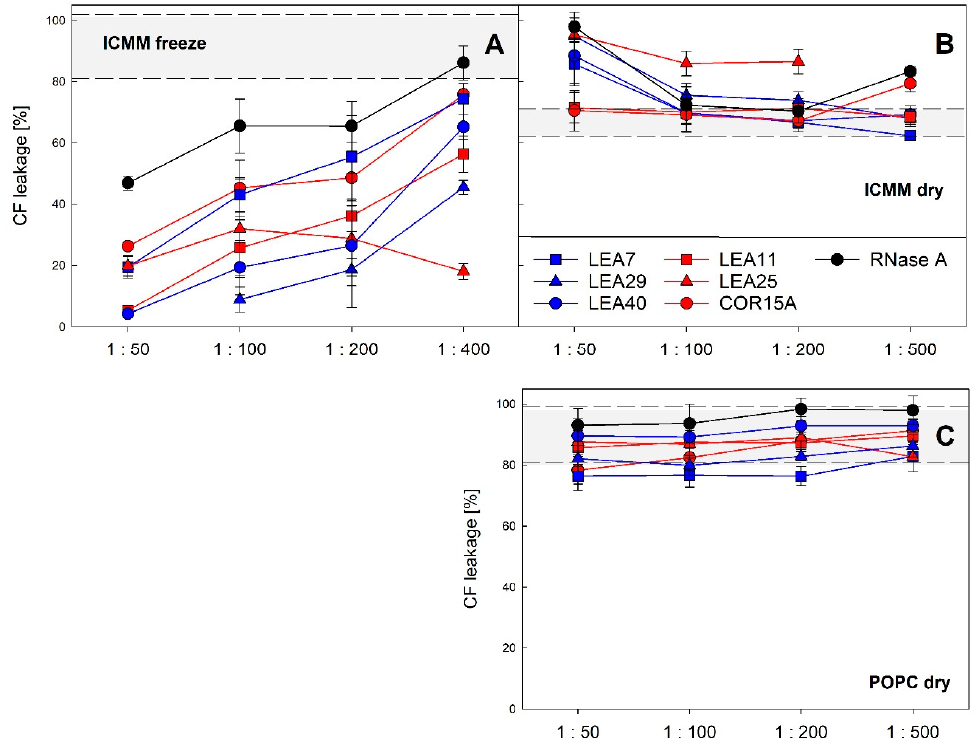
Figure 13. Liposome stability after a freeze/thaw cycle (A) or a dehydration/rehydration cycle (B, C). The integrity of large unilamellar ICMM vesicles, composed of 40% monogalactosyldiacylglycerol (MGDG), 30% digalactosyldiacylglycerol (DGDG), 15% sulfoquinovosyldiacylglycerol (SQDG) and 15% egg phosphatidylglycerol (EPG) (A, B) or of pure 1-palmitoyl-2-oleoyl-phosphatidylcholine (POPC) (C) was assayed as leakage of the soluble marker CF. The samples contained the indicated LEA_4 proteins or RNase A as reference protein at different protein-lipid mass ratios. Grey shaded areas depict average values for liposomes frozen or dried in the absence of protein, limited by ± SD. The averages of three replicates from one to three independent experiments are shown ± SD. As reported previously, all three proteins constituting the COR15A clade stabilized ICMM liposomes during a freeze/thaw cycle [30]. The same was true for the three proteins of the LEA7 clade. In most cases, the degree of stabilization depended on the protein: lipid ratio, suggesting that vesicle stabilization is related to vesicle surface coverage. The most efficient stabilizers were LEA29, LEA11 and LEA40, which showed a similar performance, followed by COR15A and LEA7. LEA25 performed differently, as it stabilized liposomes independent of protein concentration in the investigated range of protein:lipid ratios. The differences in vesicle protection observed among the six proteins were not related to membership in the two clades. During dehydration/rehydration none of the six LEA_4 proteins showed a stabilizing effect for either ICMM or POPC liposomes. In contrast to freezing, LEA25, LEA29 and LEA40 even destabilized ICMM liposomes at high protein concentrations under these conditions. While LEA proteins affected ICMM stability under both treatments, they had no significant effect on POPC stability during a dehydration/rehydration cycle. 3. Discussion LEA proteins are widely considered as protectants during abiotic stresses involving cellular dehydration. Their disordered nature at full hydration and folding in response to various